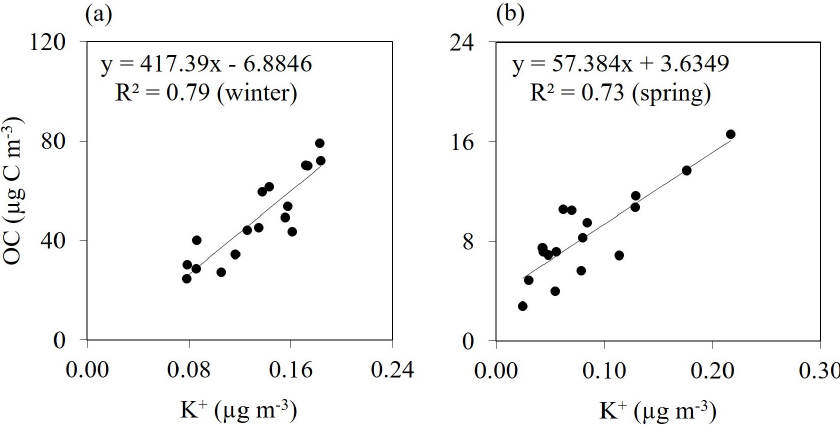
Figure 8. Correlation between PM 2 . 5 concentrations of (a) OC (µgCm − 3 ) and levoglucosan (µgm − 3 ) and between (b) K + and levoglu- cosan (µgm − 3 ) during winter and spring of 2017.